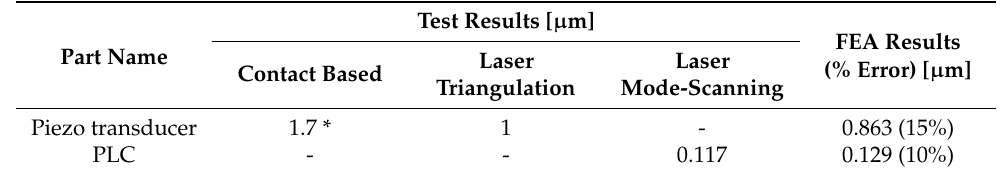
Table 3. Numerical